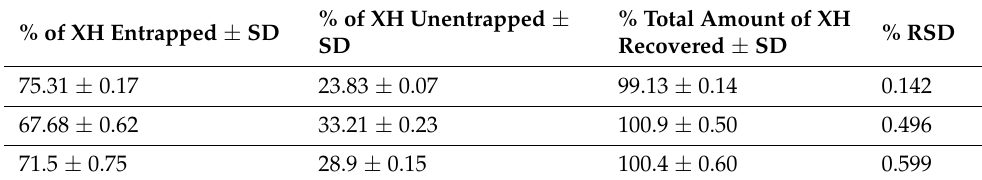
blank lipoid S E80 ( D ) XH loaded SLN. Table 8. A percentage entrapment efficiency study of XH in SLNs (n =